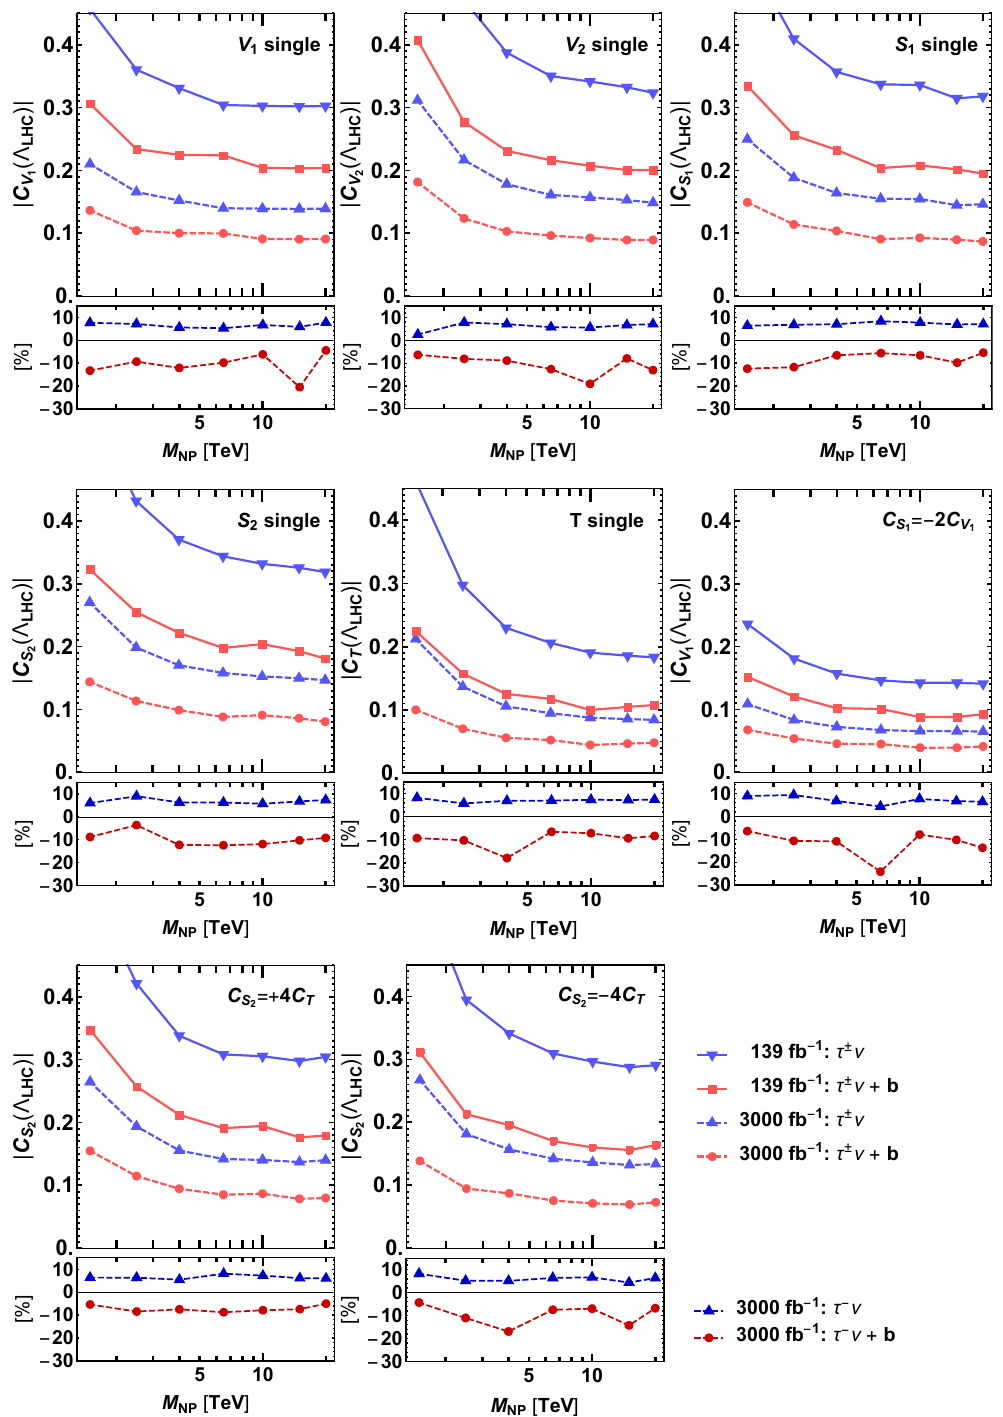
Figure 1 . Expected sensitivities to the absolute value of C X (Λ LHC ) (upper in each scenario) with R L dt = 139 fb − 1 (solid) and 3000 fb − 1 (dashed) in the τ ± ν (blue) and τ ± ν + b (red) searches. In /C 95% | the lower plot of each scenario, δC 95% τ ± is displayed for X X C 95% | − C 95% | C 95% | τ ± τ − , where τ − ( ± ) is the sensitivity to the WC with (without) selecting X X X